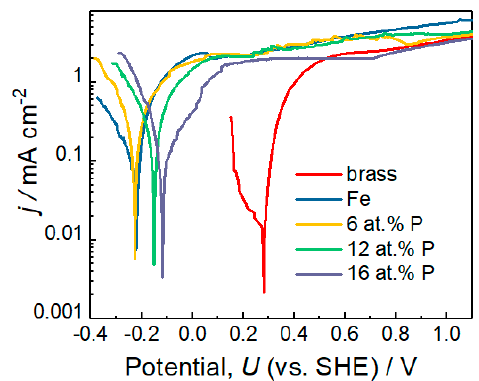
Figure 7. Potentiodynamic polarization curves of Fe-P coatings with various phosphorous content, compared with Fe and brass (substrate). In 0.05 M H 2 SO 4 . Fe-6 at.% P (Gly 0 M), Fe-12 at.% P (Gly 0.11 M), and Fe-16 at.% P (Gly 0.64 M). Table 3. Corrosion potential ( U corr ), corrosion current density ( j corr ), corrosion resistance ρ corr of Fe-P and Fe samples.